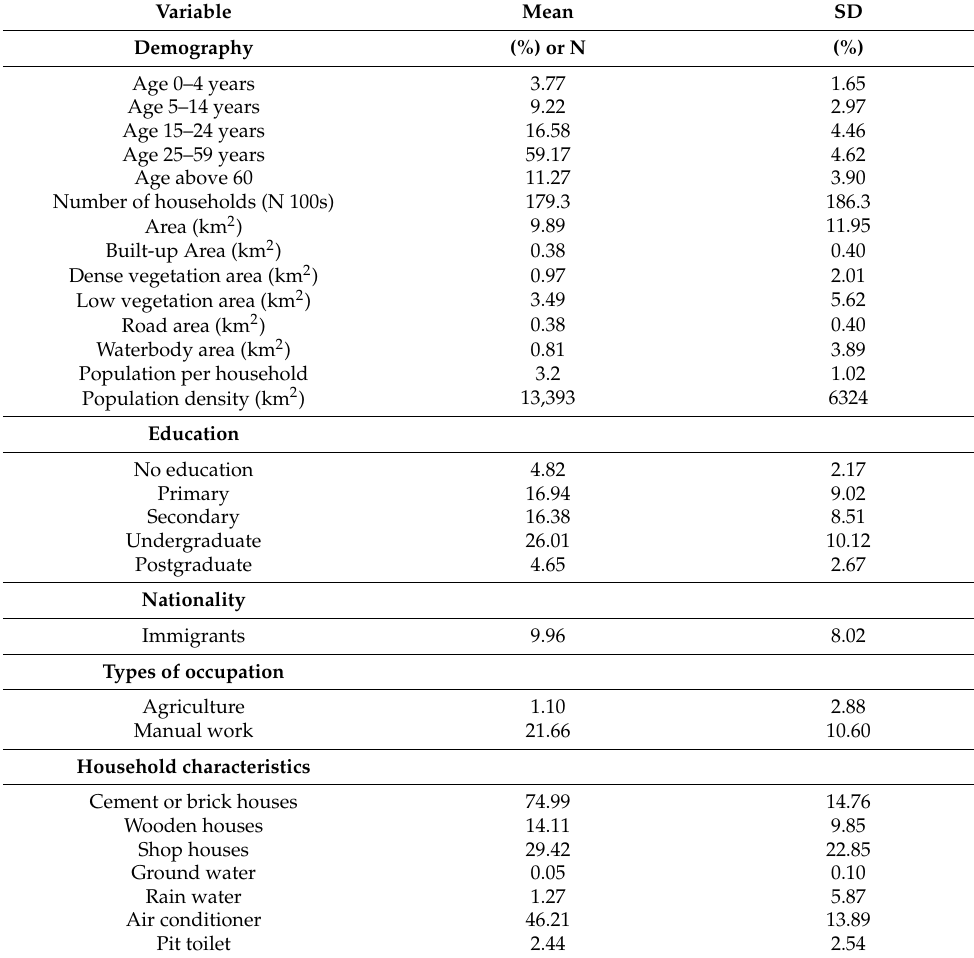
Table 2. Variation in socio-economic variables among subdistricts in